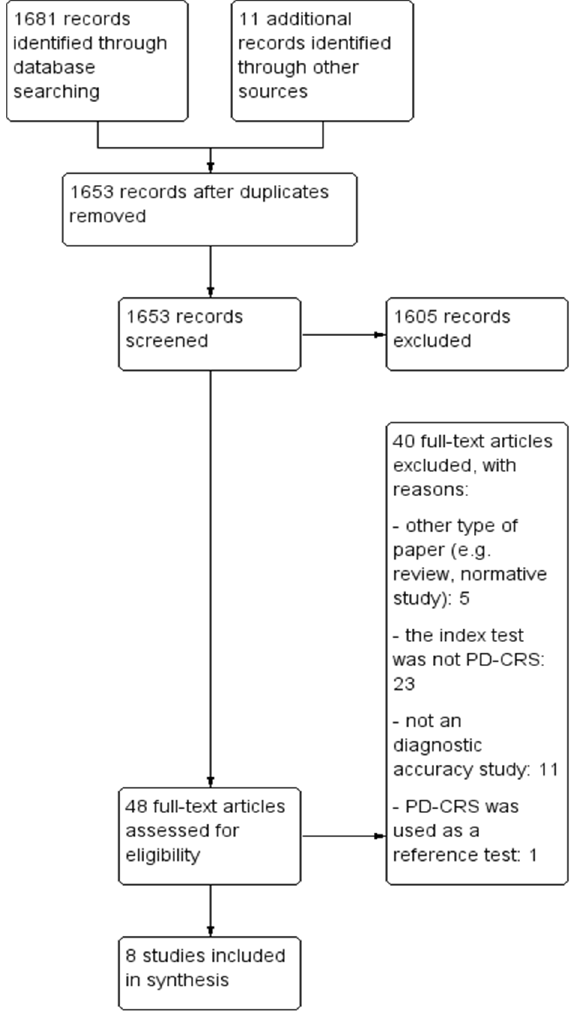
Figure 1. Study selection flow chart . PD-CRS: Parkinson’s Disease-Cognitive Rating Scale.